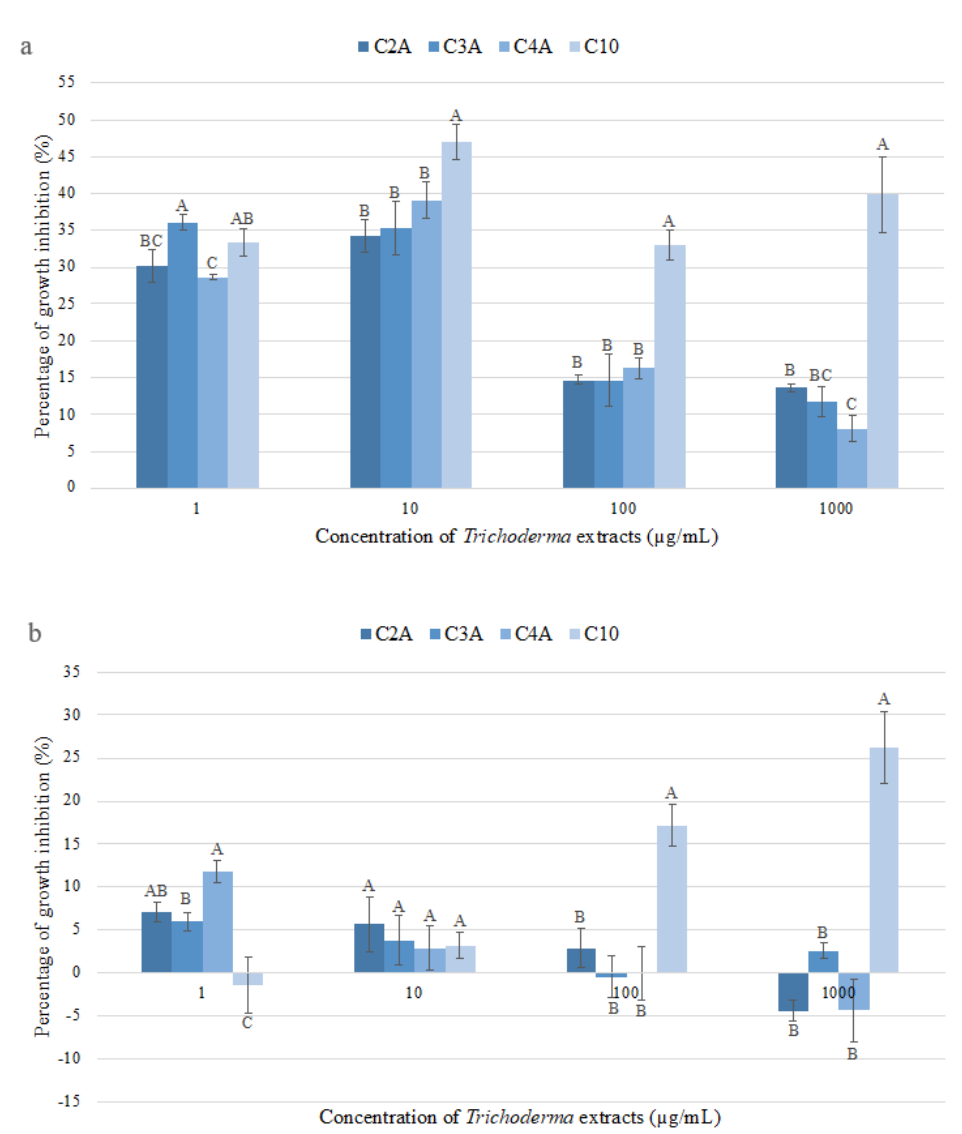
Figure 3. Percentage of growth inhibition (PGI) of Trichoderma spp. ethyl acetate extracts on cocoa pathogens ( a ) M. perniciosa and ( b ) M. roreri. Values are expressed as mean ( n = 4) ± standard error. The same letter indicates values that are not significantly different among extracts at the assessed concentrations using Tukey’s test at ( p < 0.05). C2A = T. reesei , C3A = T. sp., C4A = T. harzianum